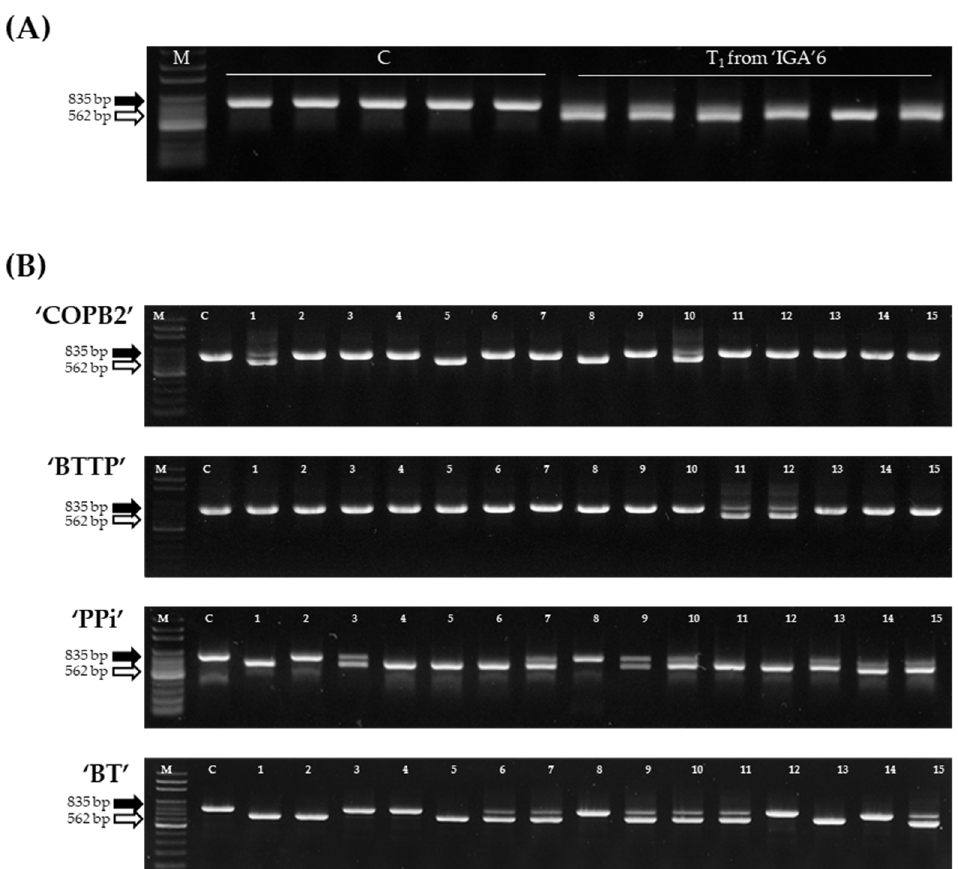
Figure 3. The activation analysis of the PTE-2 by MIP PCR analysis. ( A ) MIP PCR analysis of the PTE-2 in the control line, ‘CT001’ and the ‘IGA’ transgenic lines. M, 100 bp DNA ladder; C, ‘CT001’; lane, ‘IGA’ transgenic lines of the T 1 generation advanced from ‘IGA’6. ( B ) MIP PCR analysis of the PTE-2 in the control line, ‘CT001’ and four transgenic lines (‘COPB2’, ‘BTTP’, ‘PPi’, and ‘BT’). M, 100 bp DNA ladder; C, ‘CT001’; Lane, the transgenic lines. Black arrow, PTE-2 -inserted amplicon; White arrow, PTE-2 -excised amplicon.